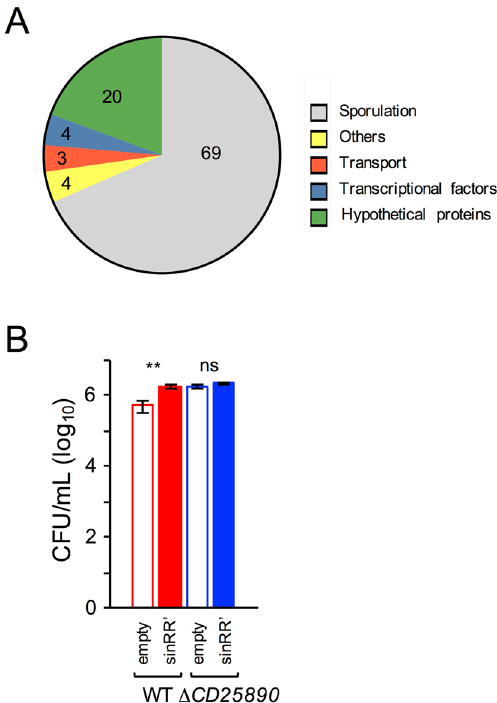
Figure 6. Differential gene expression in the (cid:31) CD25890 mutant. ( A ) To compare the transcriptome of the (cid:31) CD25890 mutant with the wild type, both strains were grown for 10 h in SM broth, samples collected and RNA-seq performed. The graph represents the functional classes of the 165 genes that are up-regulated in the (cid:31) CD25890 mutant based on the RNA seq data (the number represent the percentage of each functional class). See also Table S3. ( B ) Sporulation efficiency of the P tet - sinRR’ alleles. The spore titer was determined 24 h following inoculation into SM sporulation medium supplemented with 50 nM of anhydrotetracycline. The heat resistant spore count by determining the cfu/mL obtained after treatment at 70ºC. The results shown are averages and standard deviations for three biological